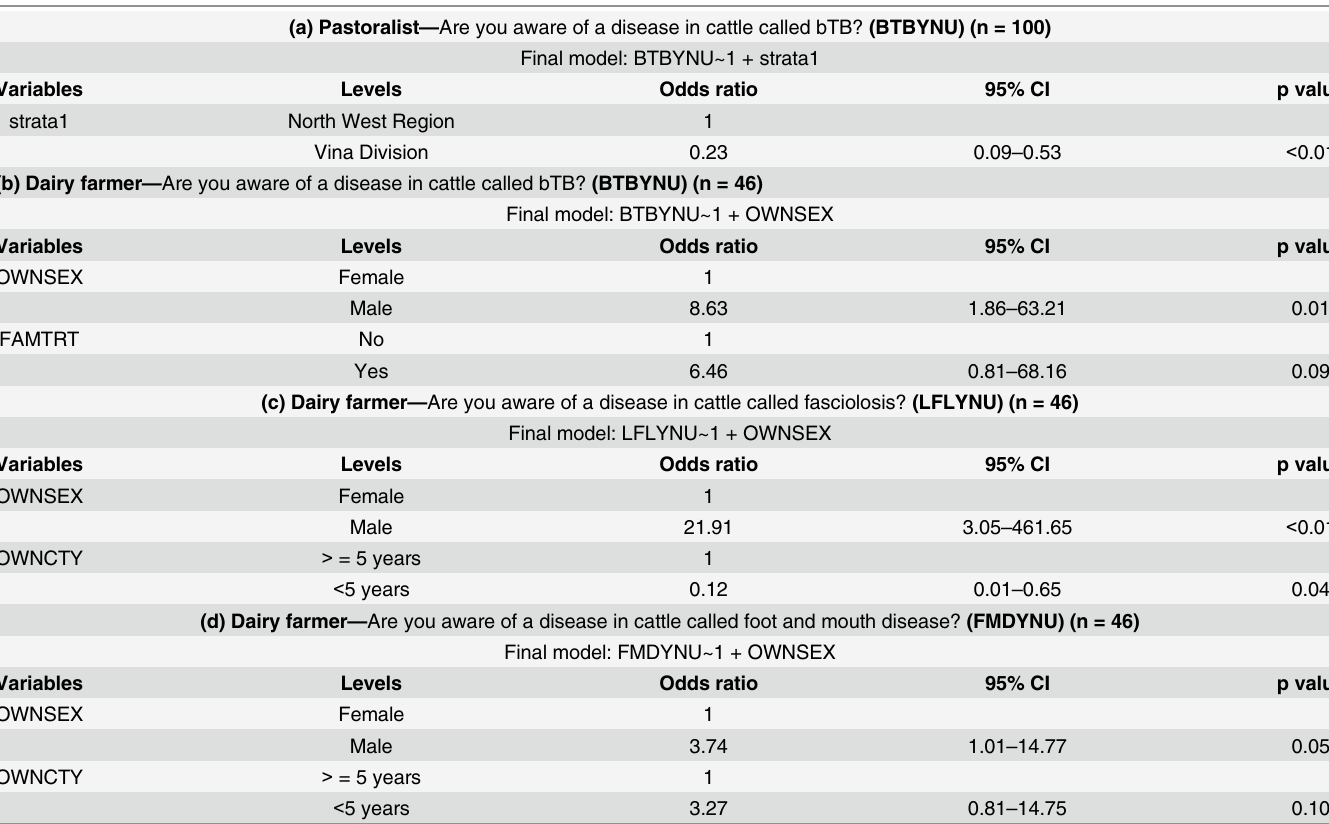
Table 3. Final mixed-effects logistic regression risk factor models for disease awareness. (a) “ Are you aware of a disease in cattle called bTB? ” (BTBYNU) in pastoralists (n = 100), (b) “ Are you aware of a disease in cattle called bTB? ” (BTBYNU) in dairy farmers (n = 46), (c) “ Are you aware of a disease in cattle called fasciolosis? ” (LFLYNU) in dairy farmers (n = 46,) and (d) “ Are you aware of a disease in cattle called foot and mouth disease? ” (FMDYNU) in dairy farmers (n = 46). Explanatory variables included are OWNSEX (Gender) and strata1 (Pastoralist study